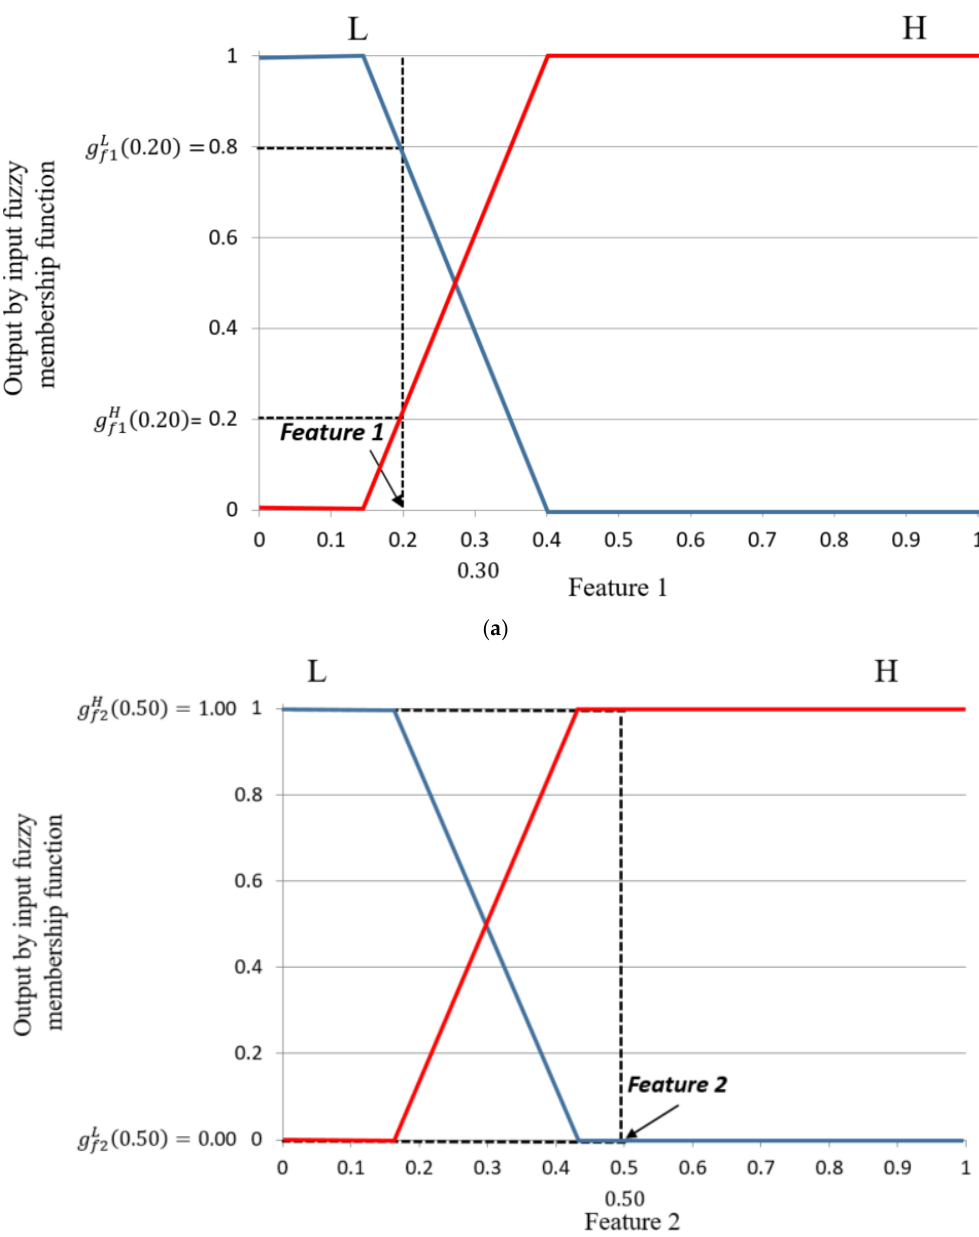
Table 3. IVs obtained with four combinations.